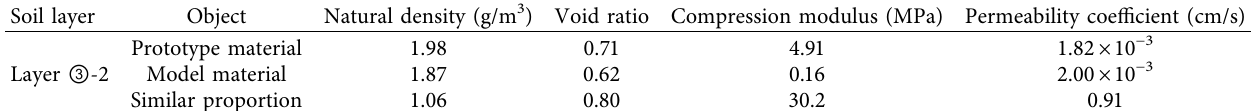
Table 3: Ratio of main physical and mechanical indexes between the prototype materials and the model materials.